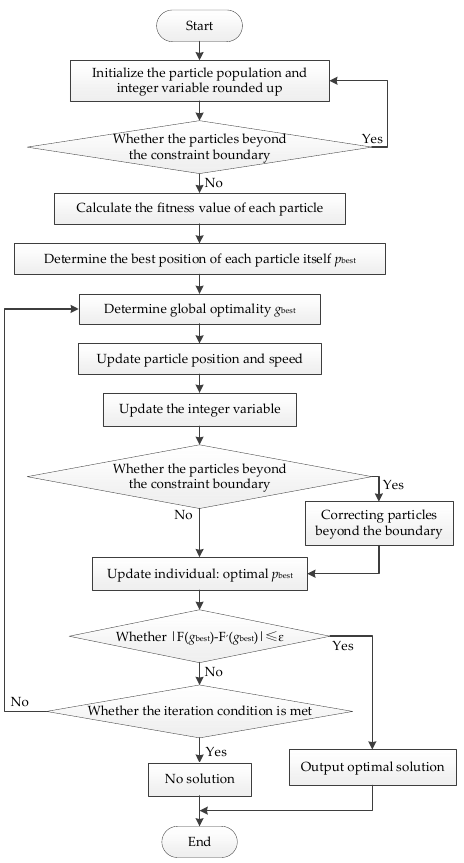
Figure A1. Particle swarm optimization flowchart.